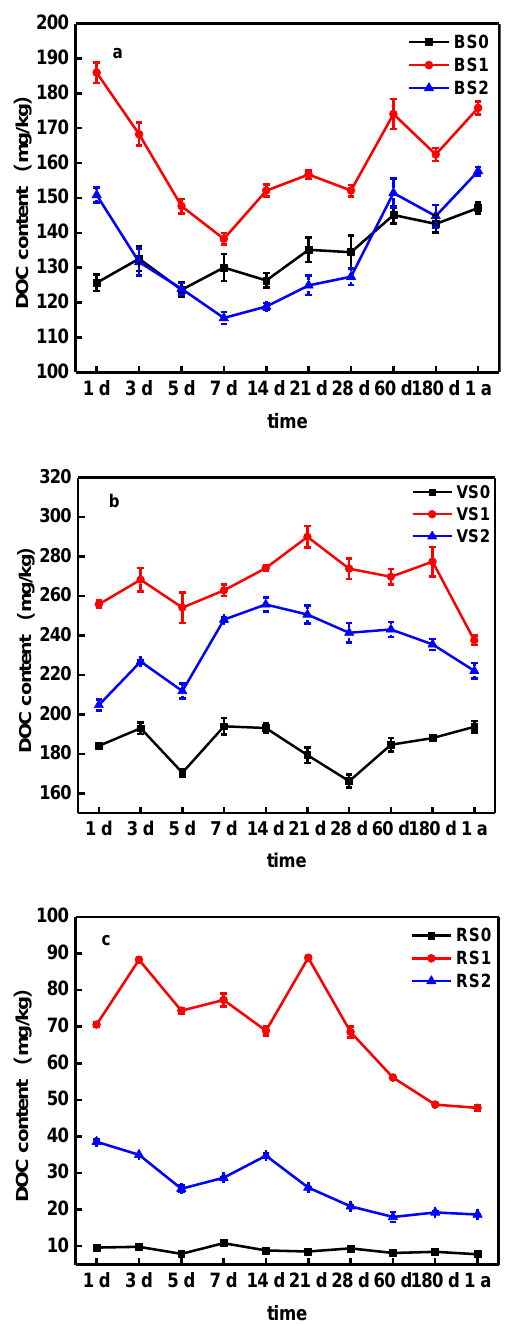
Figure 3. The change in DOC content in BS ( a ), VS ( b ) and RS ( c ) soils amended with biochars. Note: Error bars are standard deviations of the means ( n = 3).